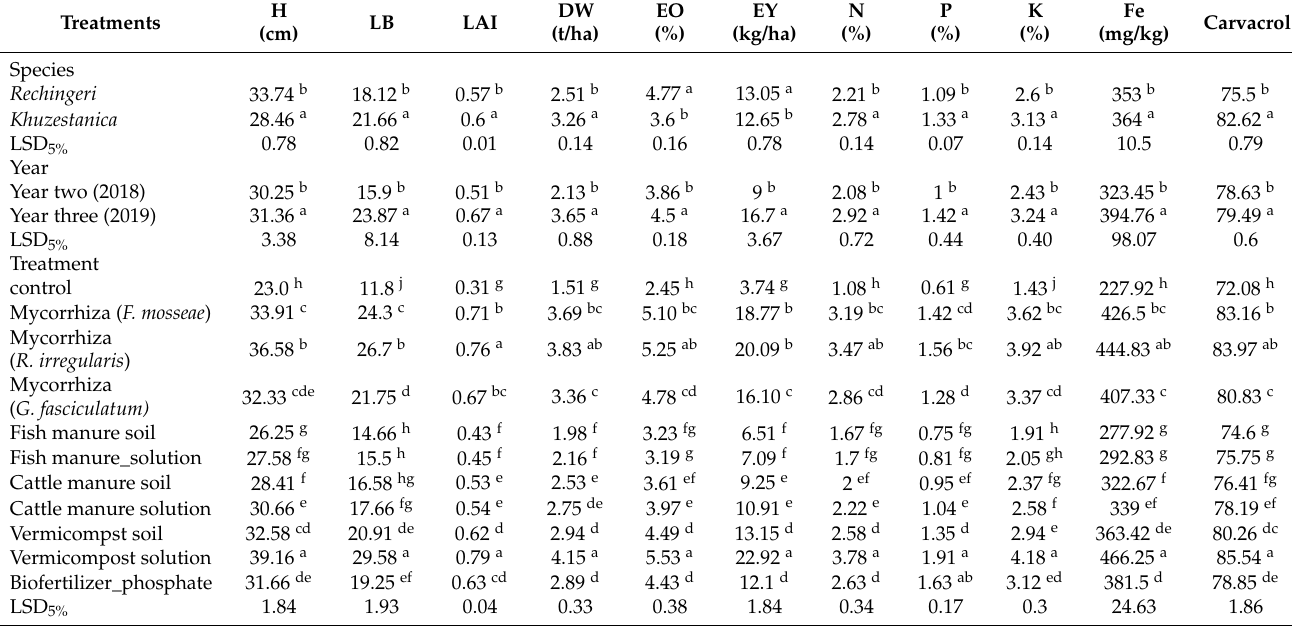
Table 5. Mean comparison of some measured characters of savory.